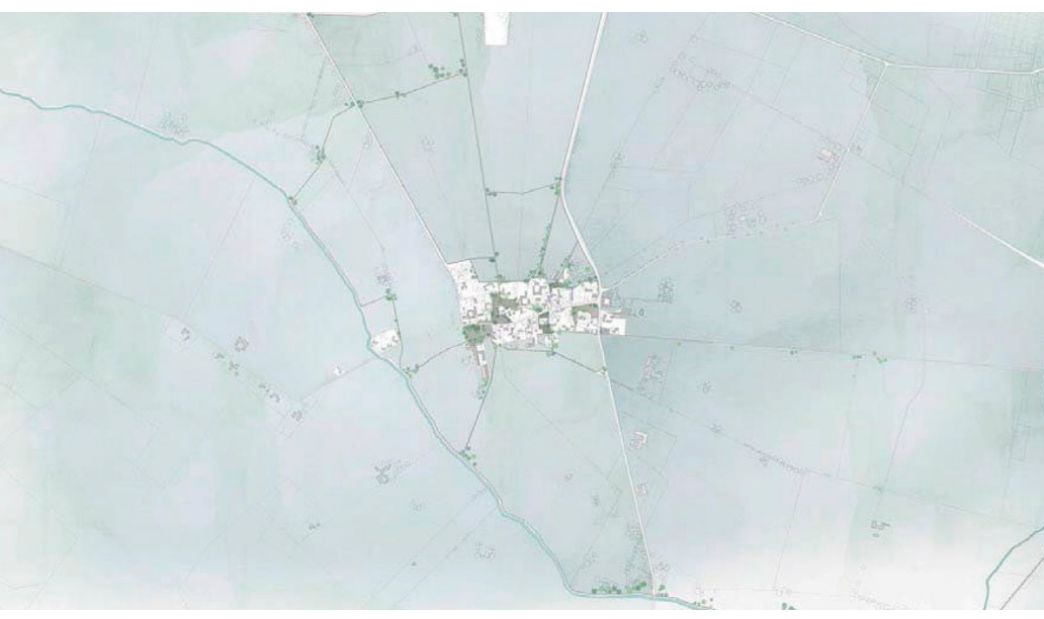
Figure 9. Plan of Høve with pathways in the landscape.